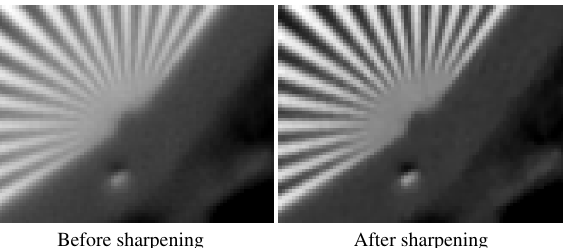
Before sharpening After sharpening Figure 4. Illustration of the effect of the sharpening step on the reconstruction. The image on the right (with sharpening) is more contrasted and less noisy than on the left (before